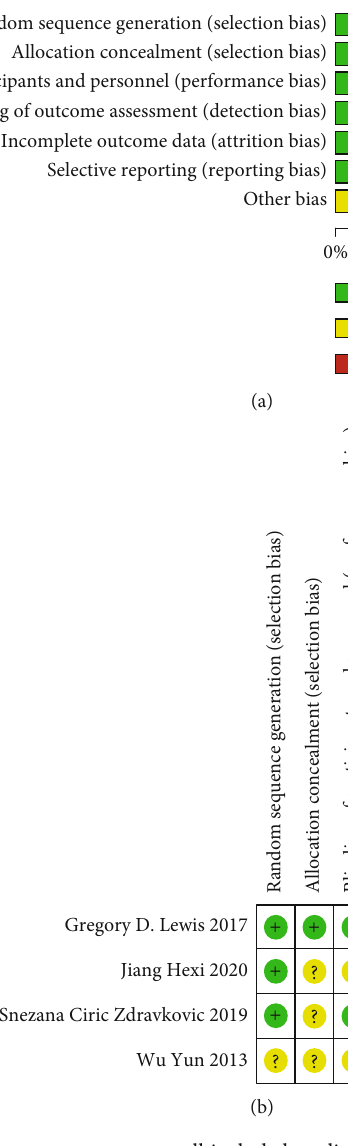
Figure 3: (a) Risk of bias assessment across all included studies; (b) risk of bias assessment for each